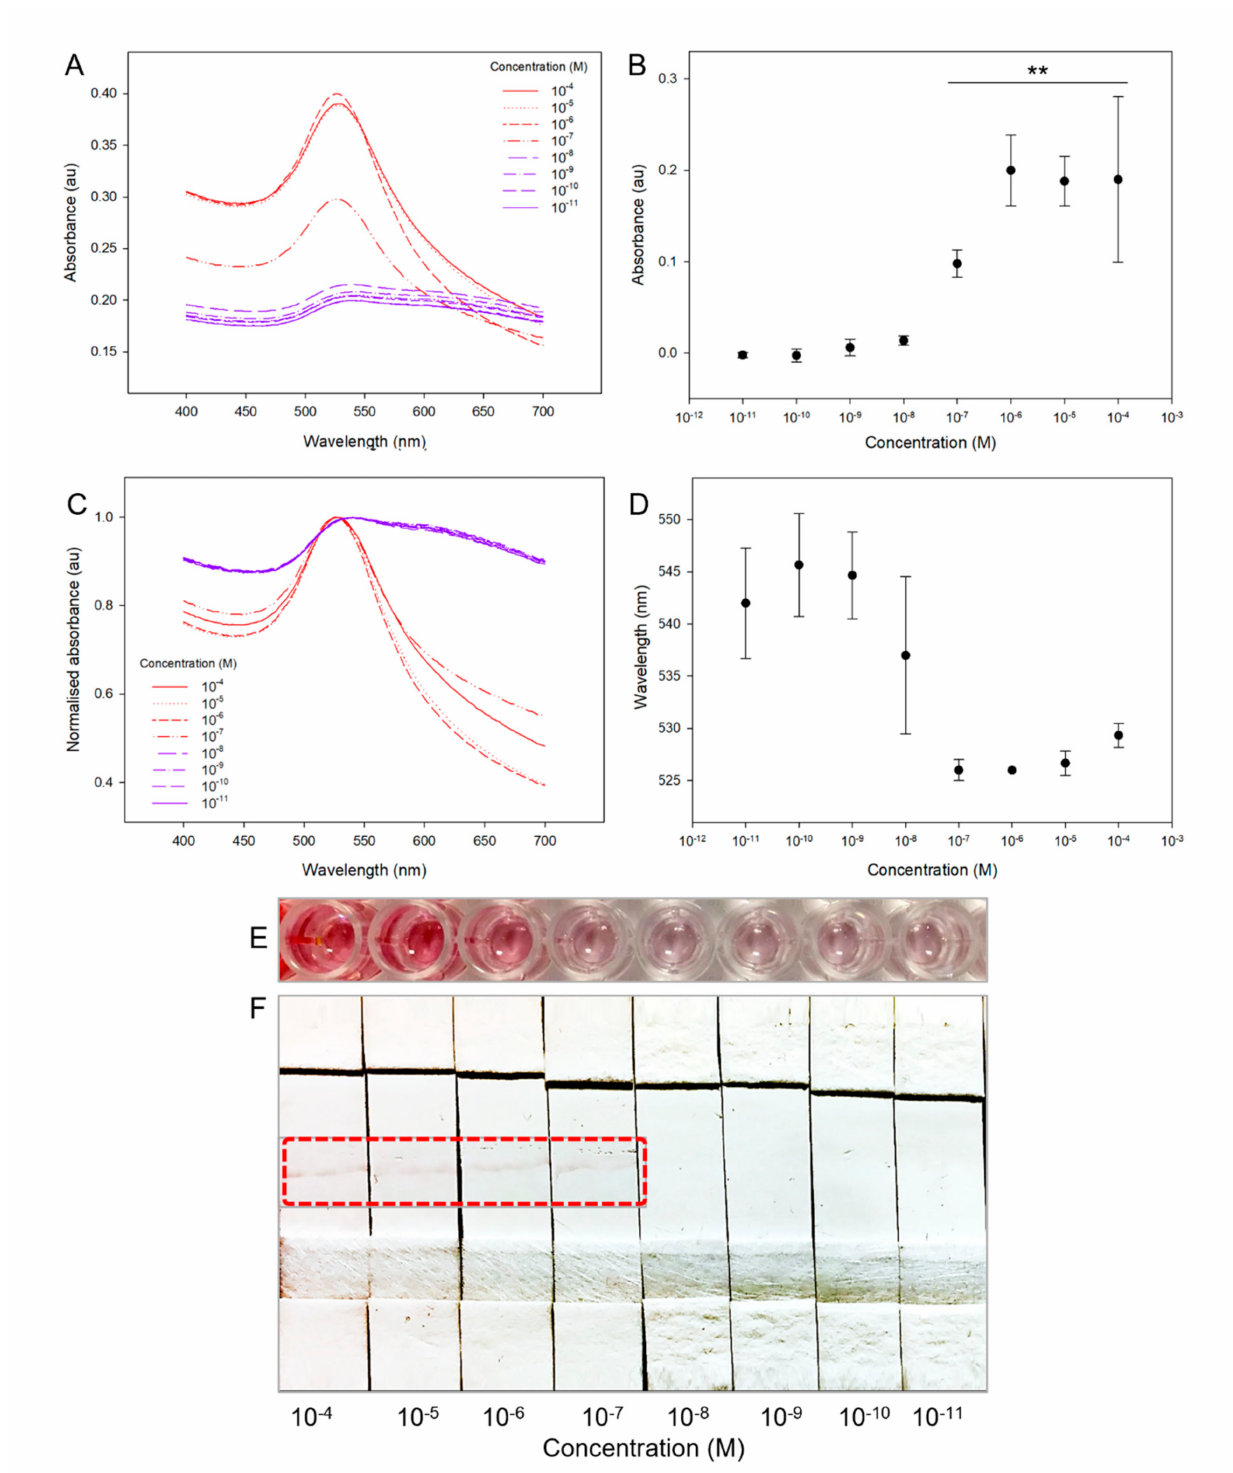
Figure 3. Response of gold–oligonucleotide nanoconstructs to conserved target enteroviral nucleic acid sequence, with concentrations ranging from 1 × 10 − 4 M to 1 × 10 − 11 M, recorded as changes in ( A , B ) absorbance intensity, ( C , D ) wavelength redshift, ( E ) optical colour change, and ( F ) lateral flow assay, with region of interest highlighted with red dotted line, indicating detection of target nucleic acid sequence. Please note that the light band positioned at the centre of the lateral flow device indicates location of streptavidin deposition. Calibration curves show changes in ( B ) absorbance maxima with subtraction of background absorbance, and ( D ) wavelength ( n = 3, where error is standard deviation and ** p <